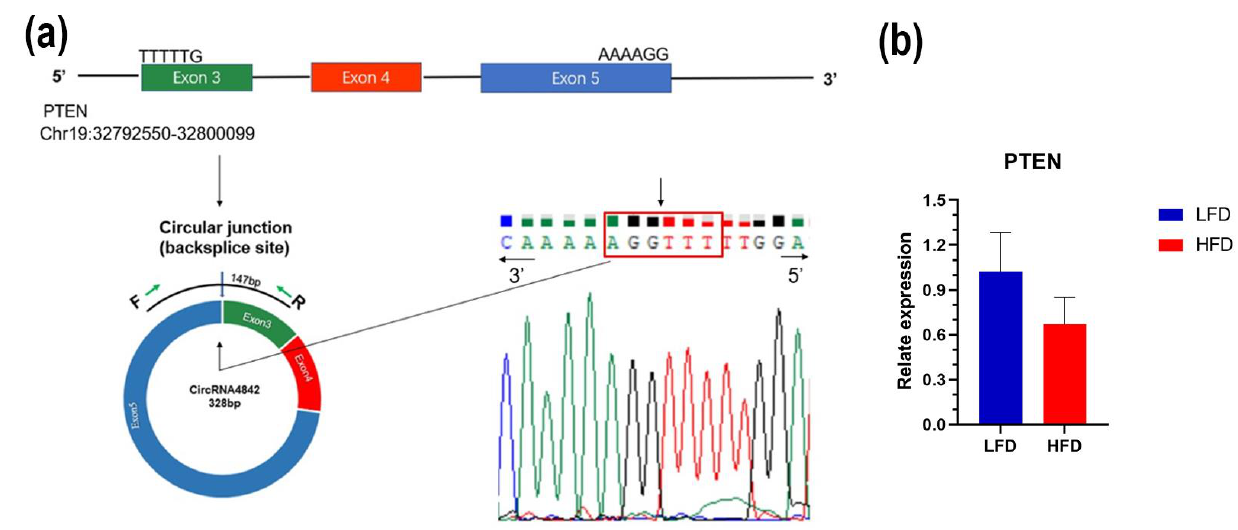
Figure 6. Validation of the circRNA4842 and its parental gene. ( a ) Divergent primers were designed for circRNA4842 validation; ( b ) relative expression levels of PTEN .